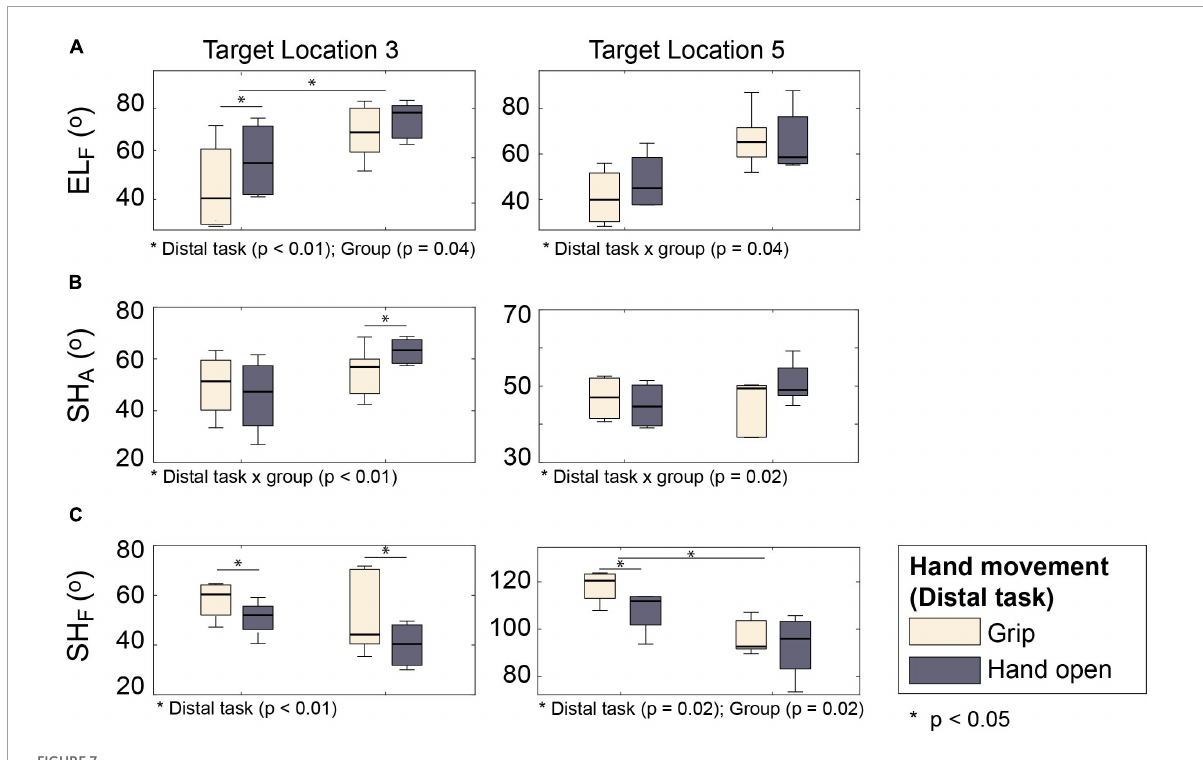
FIGURE7 Proximal kinematics of two subject groups under two distal task conditions ( P AF T 1 vs. P AF T 2 ). (A) Elbow flexion (EL F ). (B) Shoulder abduction (SH A ). (C) Shoulder flexion (SH F ).